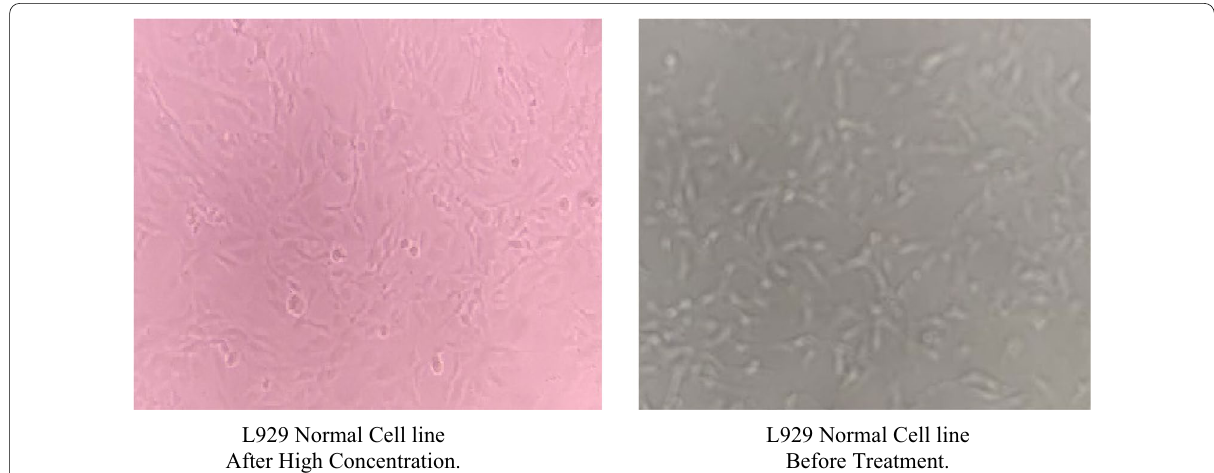
Fig. 4 Images of L929 Normal Cell line before treatment and after treatment with high concentration of ETHE of C. pluricaulis